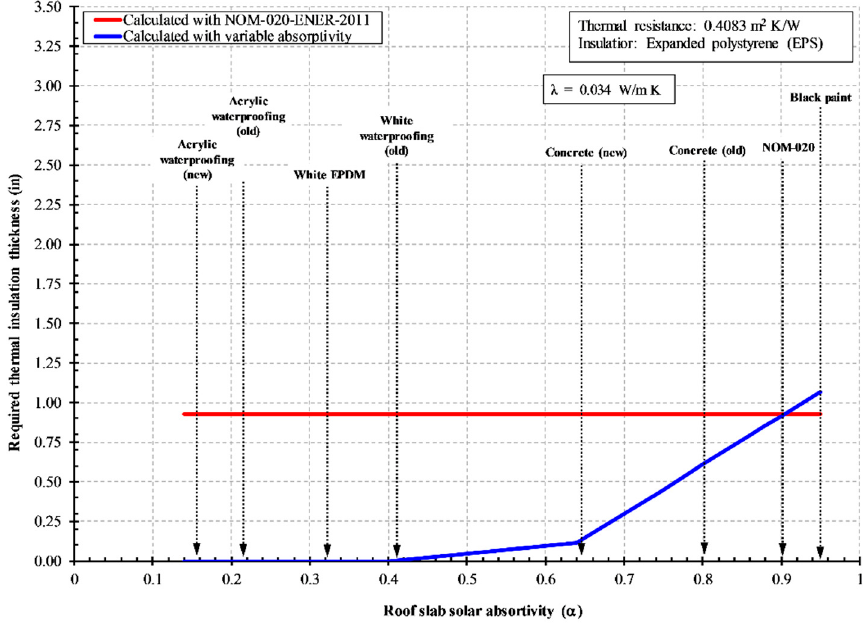
Figure 10. Roof insulation required to comply with NOM-020 in Mexico City. Table 2. Thermal resistivity of a slab roof.